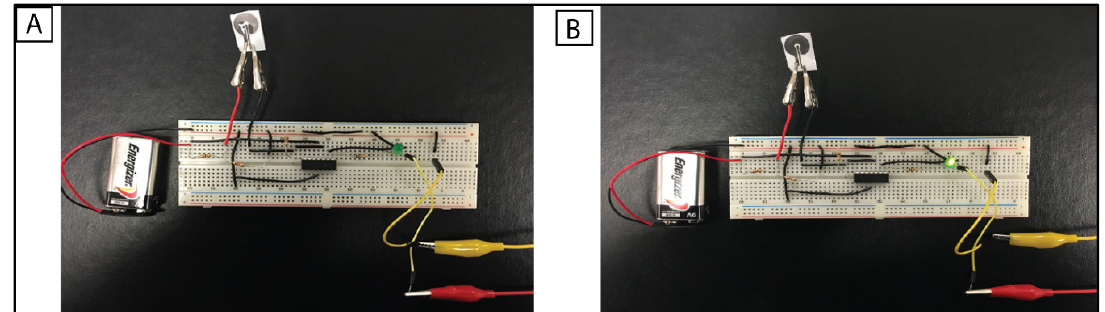
Figure 6. Electrical prototype of an optical reader for cTnI detection. ( A ) Optical reader indicating an “OFF” output state on an antibody conjugated sensor; ( B ) optical reader indicating an “ON” state upon the addition of antigen sample. The binding between of biomolecules decreases the impedance below the threshold value thereby turning the output LED to “ON” state.